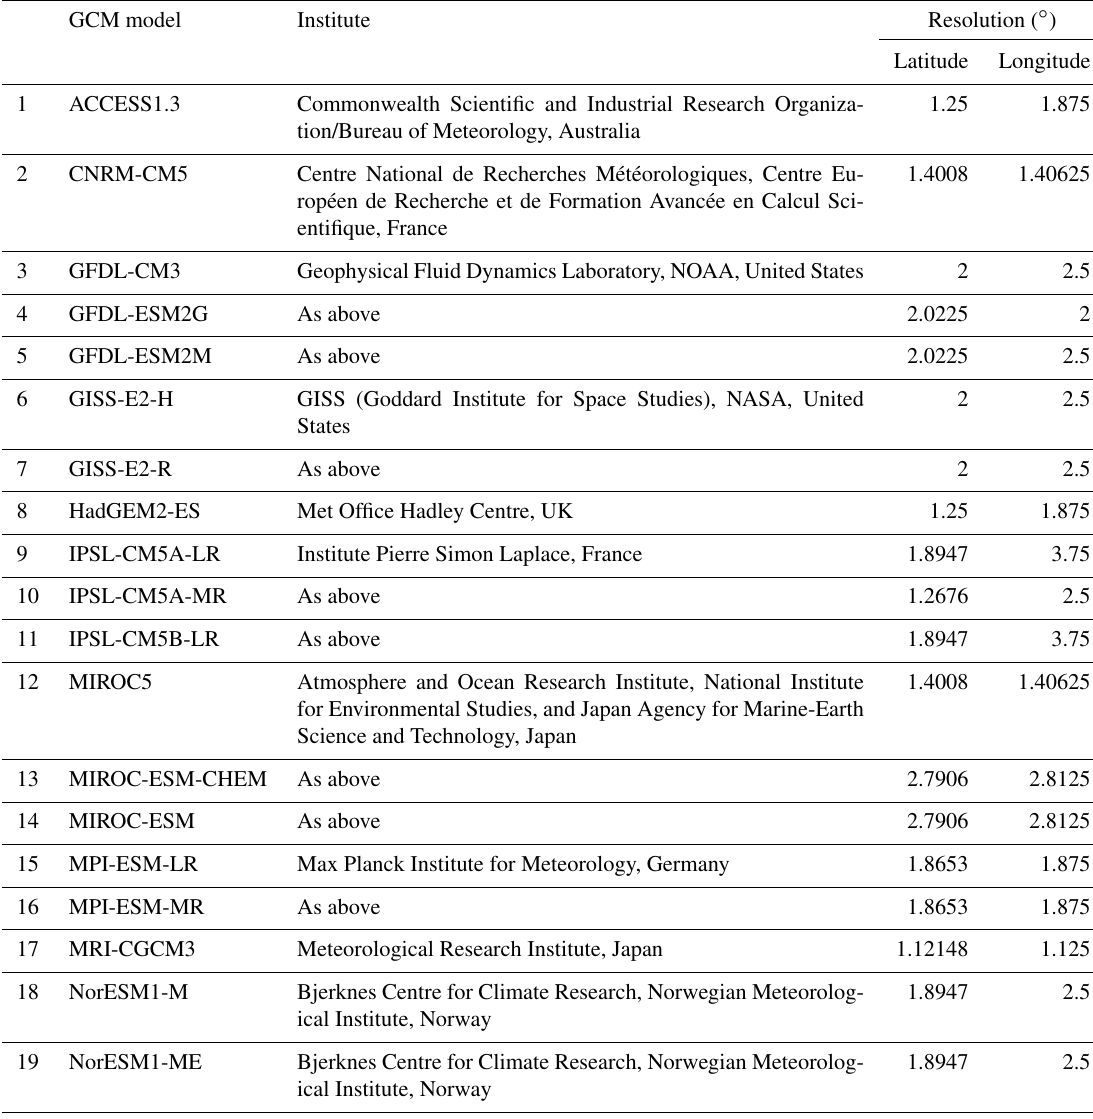
Table 1. GCMs used for reliability